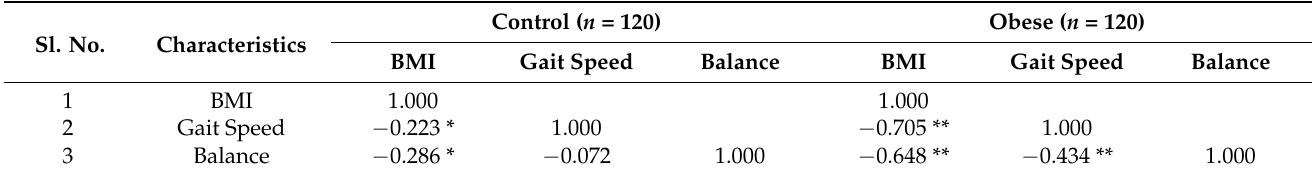
Table 2. Correlation matrix of BMI, gait speed, and balance (Pearson’s